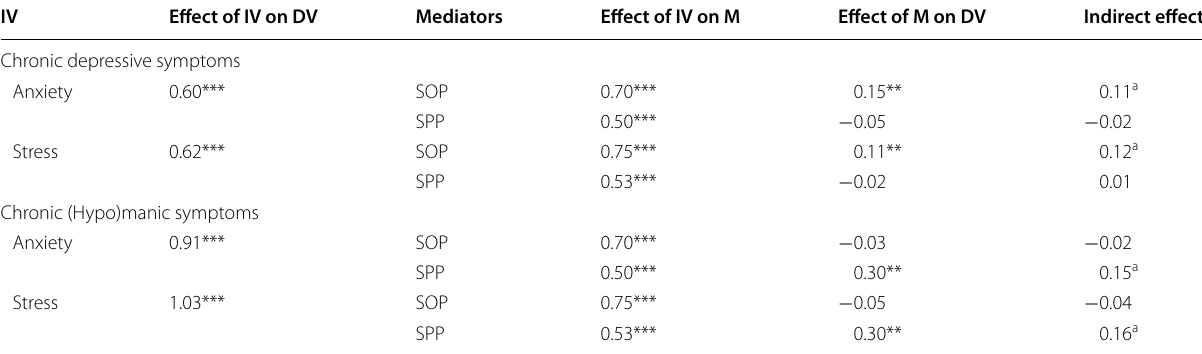
IV independent variable, M mediating variable, DV dependent variable, SOP self-oriented perfectionism, SPP socially-prescribed perfectionism * p < 0.05; ** p < 0.01; *** p < 0.001